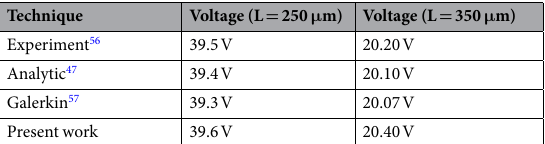
Table 2. Comparison of the sensor threshold voltage with the experimental, analytical and numerical results from the literature.